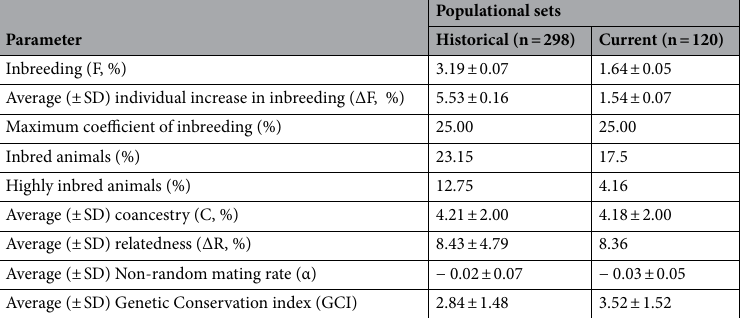
Table 3. Statistics of identity by descent estimators, non-random mating degree and genetic conservation index.